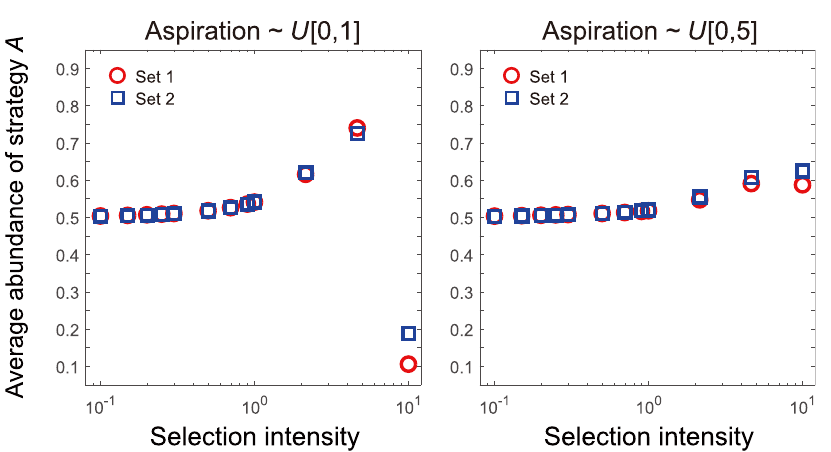
Fig 3. Robustness of the evolutionary outcome based on the way of payoff accumulation. Individuals are now participating in three games for a time. One of the three is organised by itself and the rest two by its two nearest neighbours. The final payoff is the average of the accumulated payoff in the three games. This payoff accumulation is different from that in the theorem, where every individual only plays a single d − playergame. Yet we find that the heterogeneity of aspiration still does not change the abundance of strategy A . Thus our theorem might be generalised to other ways of payoff accumulation. Details of the simulation: The aspiration values are randomly selected from the uniform distributions on interval [0, 1] (left panel) or [0, 5] (right panel). Within each distribution, we establish two populations with different individualised aspirations. All the rest parameters are the same as those of (Fig 1).